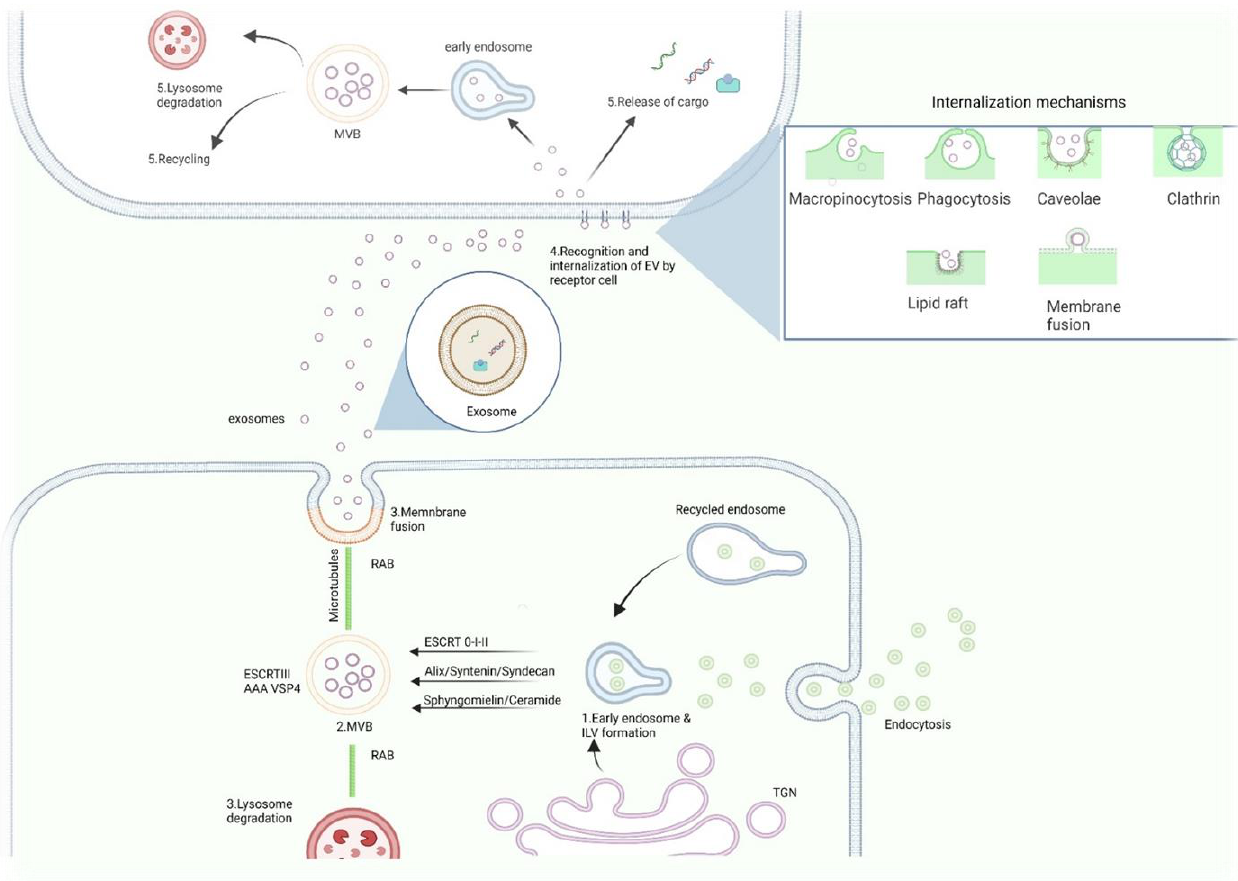
Figure 1. Biogenesis and Exosomes-Uptake. 1. Formation of early endosomes from the TGN and EVs-uptake. 2. Formation of MVB through ESCRT-dependent and independent methods. 3. Different pathways of ILV inside of the parent cell: degradation by lysosome or secretion to extracellular space. 4. Recognition of EVs by receptor cell and internalization through different means. 5. Fate of internalized EVs: release of cargo into a recipient cell to induce effect, degradation through the lysosome pathway, or recycling to repeat the cycle. EVs: extracellular vesicles; ILV: intraluminal vesicles; MVB: multivesicular body; RAB: ras related in brain GTPase; TGN: trans golgi